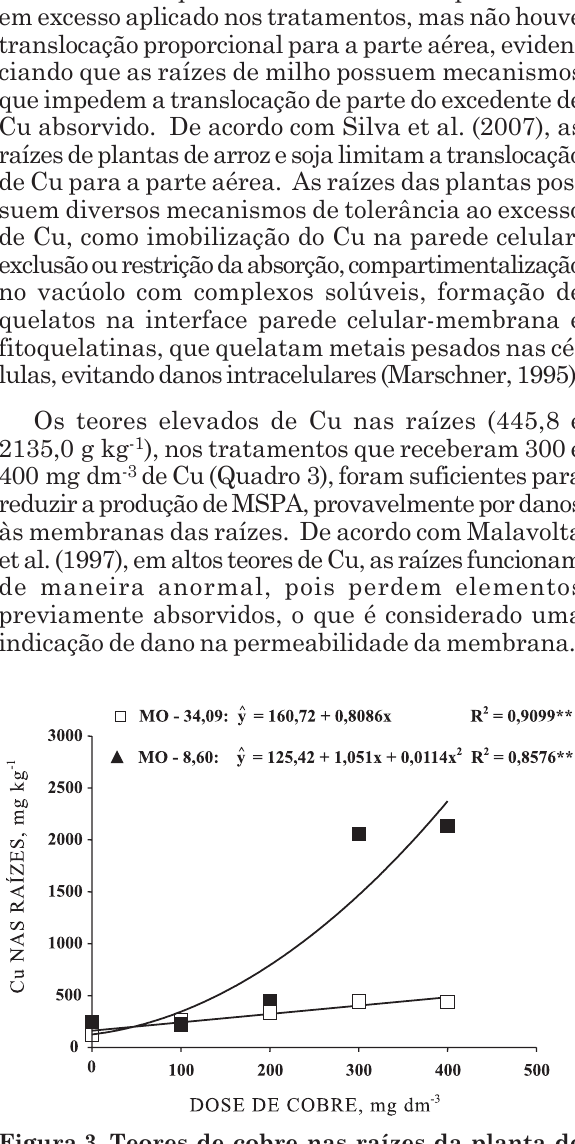
Figura 4. Teores de cobre em amostras de Latossolo Vermelho eutroférrico (duas profundidades de coleta), com dois teores de matéria orgânica, após adição de dejeto de suíno e enriquecimento com sulfato de